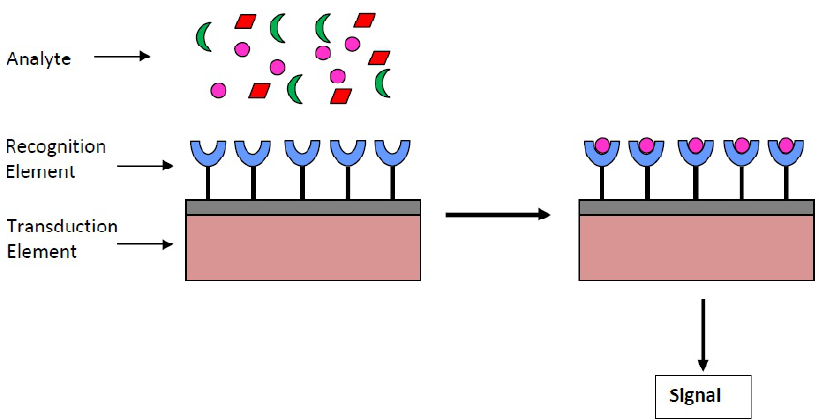
Fig. 1. Schematic diagram of biosensor consisting of a recognition and transduction